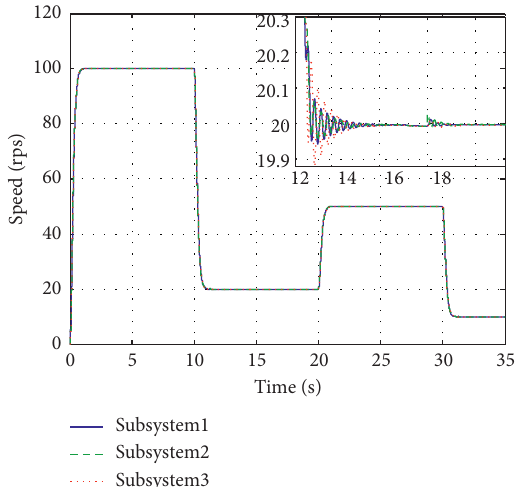
Figure 7: No FDD synchronous output after